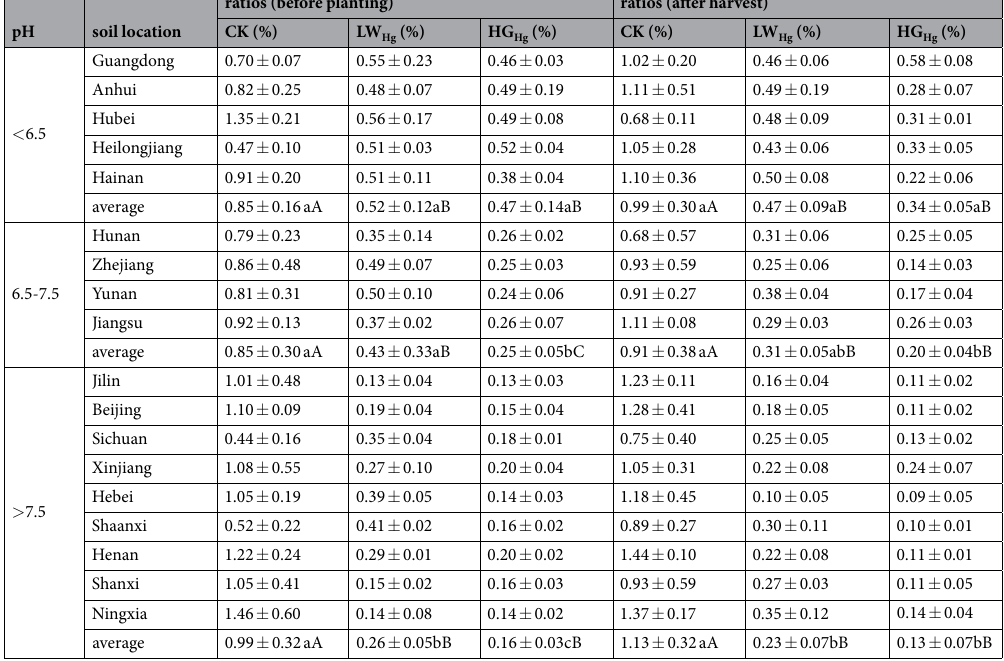
Table 1. Available and total Hg ratios in the soils before transplant and after harvest of potato. * Mean ± SD, different small letters within the same column and different capital letters within the same row for each treatment indicate a significant difference at p < 0.05 by Student’s multiple range